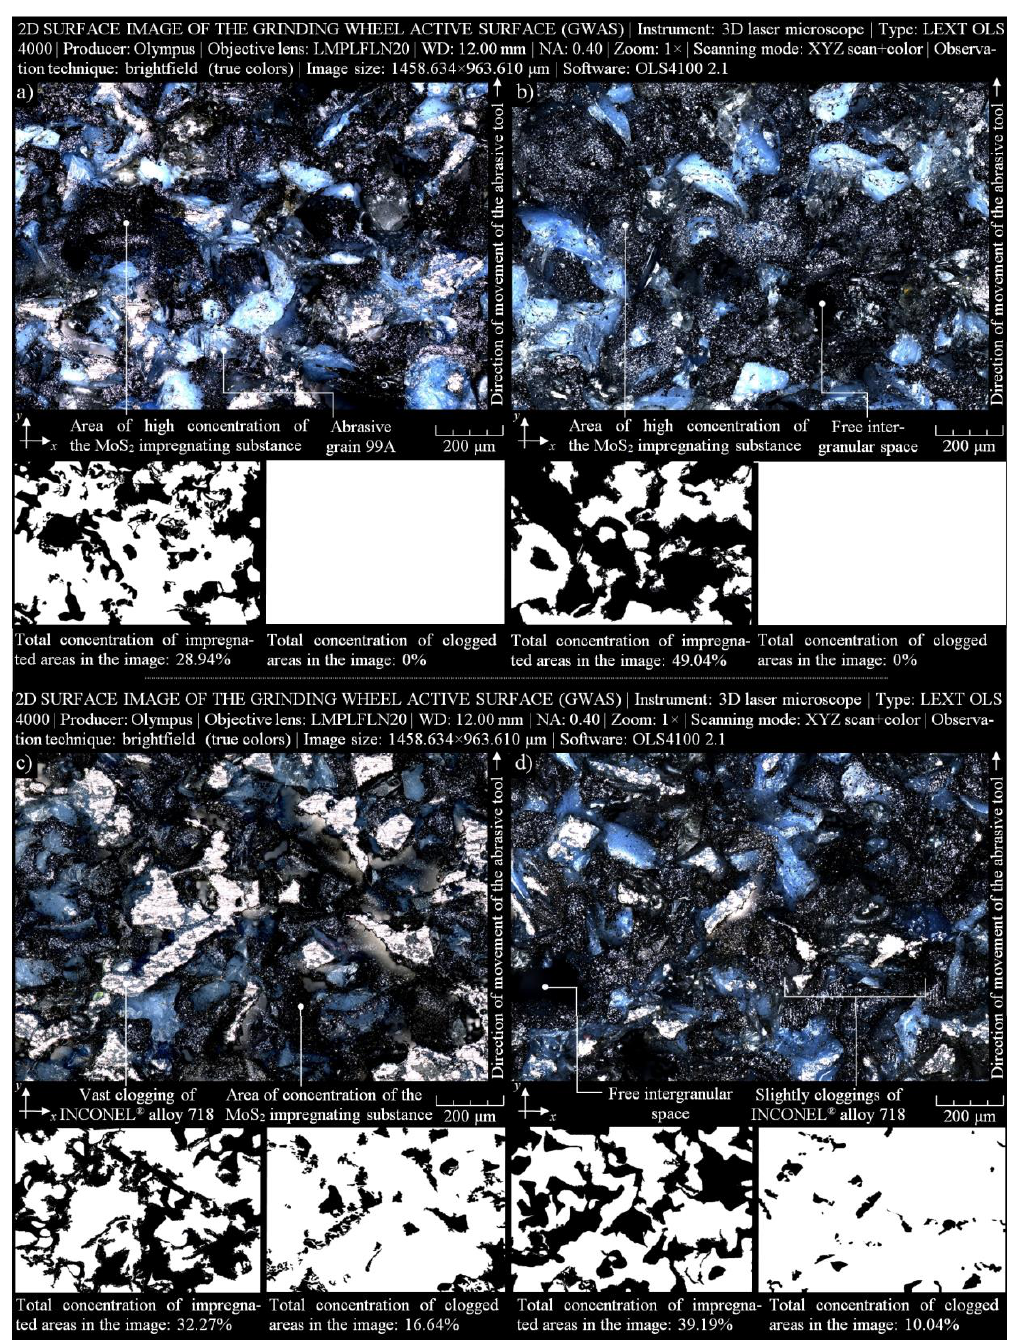
Figure 7. Collection of selected results obtained for the GWAS 1-35×10×10-9A5X60L10VE01PI-50 using a 3D laser microscope Olympus LEXT OLS4000, analyzed by Media Cybernetics Image Pro ® -Plus 5.1 software for MoS 2 -treated samples—( a ) 1M30 and ( b ) 1M40, and MoS 2 -treated samples after the internal cylindrical grinding of INCONEL ® alloy 718—( c ) 2M20 and ( d ) 2M40.